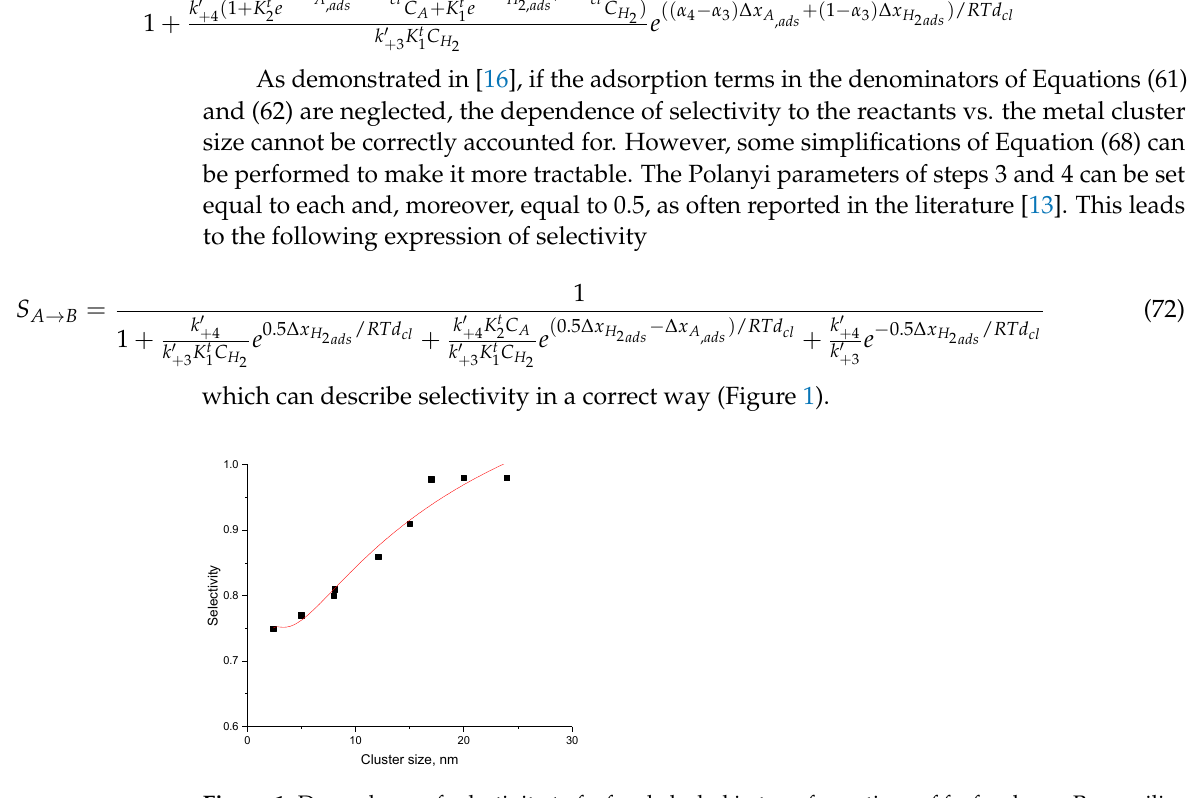
Figure 1. Dependence of selectivity to furfuryl alcohol in transformations of furfural over Ru on silica catalyst at 100 ◦ C. Experimental data digitalized from